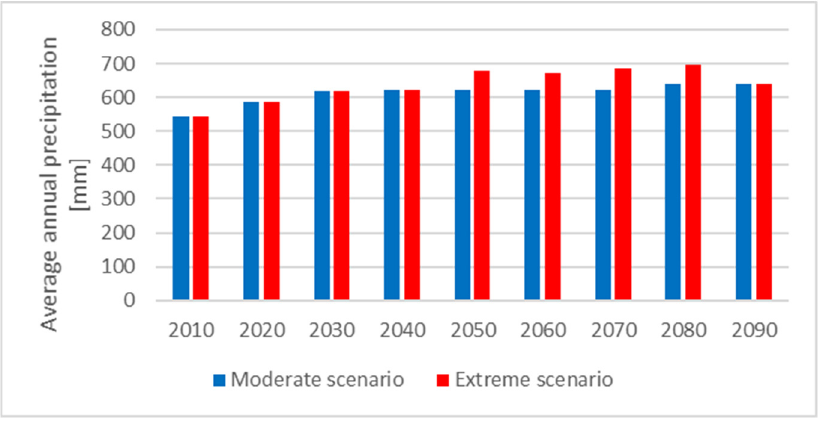
Figure 6. Precipitation projections to 2090 under an extreme climate change scenario (measuring station Bielany).